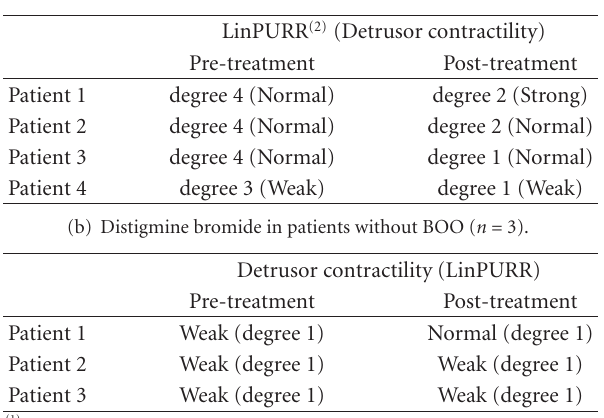
Table 4: Changes in degree of bladder outlet obstruction and status of detrusor contractility after treatments.